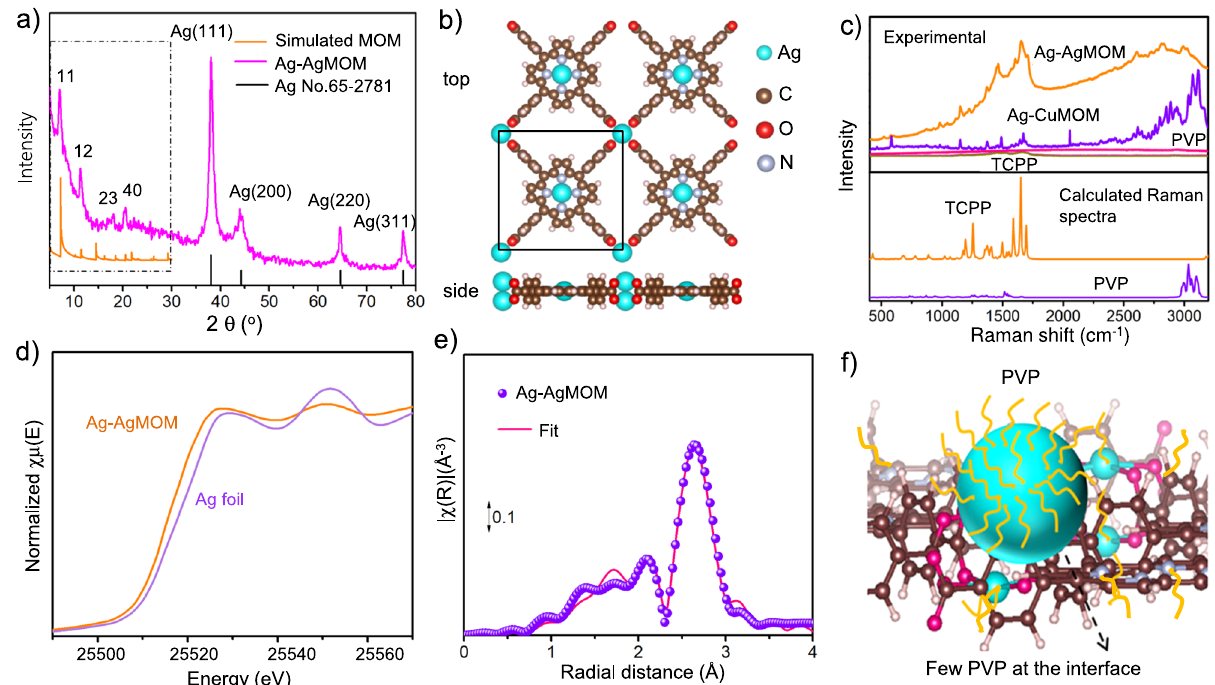
Fig. 3 | Structural characterizations of Ag – AgMOM. a XRD pattern of Ag – AgMOM, Pawley re fi nement of porphyrin based MOM from 5° to 25° and the standardpatternofAg(JCPDSNo.65-2871)from5°to80°. b DFToptimizedcrystal model of porphyrin based MOM in composites. c Raman spectra of Ag – AgMOM, Ag-CuMOM, TCPP and polyvinylpyrrolidone (PVP) taken under the excitation of a 520nm laser,and DFTcalculatedRamanspectra of TCPPand PVP (bottom fi gure).